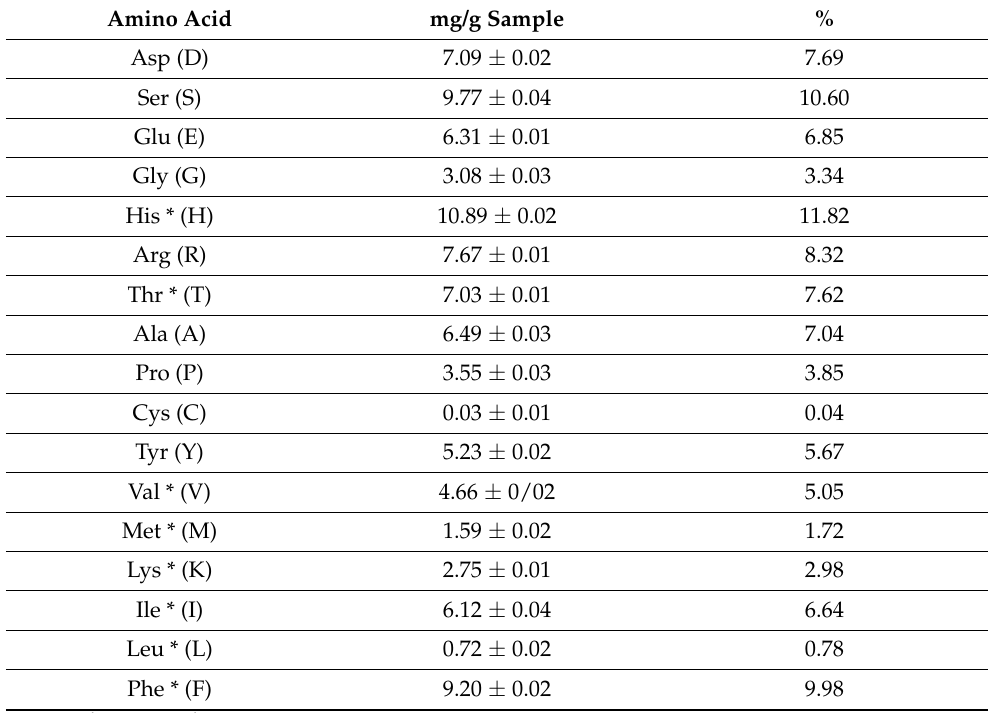
Table 3. Amino acid composition of mycelial biomass of T. versicolor NBIMCC